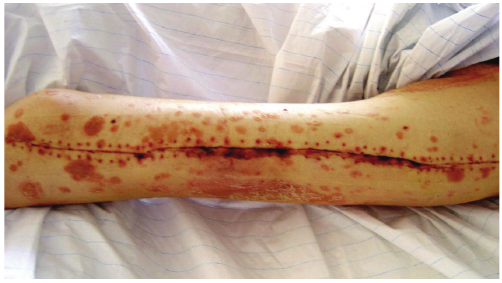
Figure 4: Left thigh 2 weeks postoperatively after removal of the